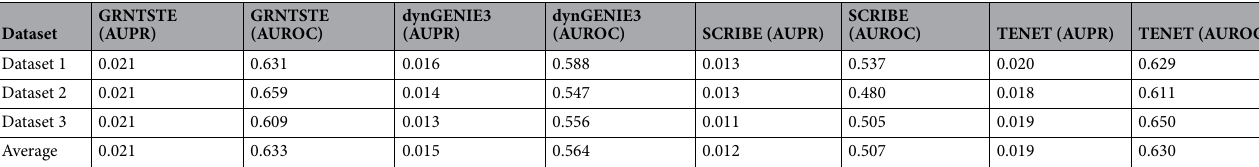
Table 2. Values of AUPRC and AUROC obtained for GRNTSTE, dynGENIE3, SCRIBE and TENET algorithms on the datasets with 50